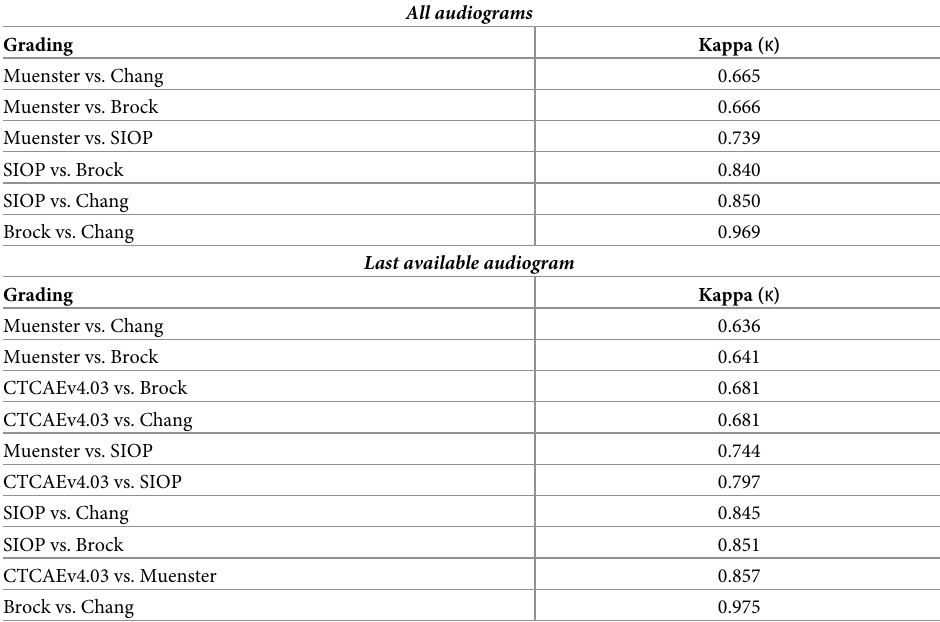
Table 5. Concordance among different ototoxicity